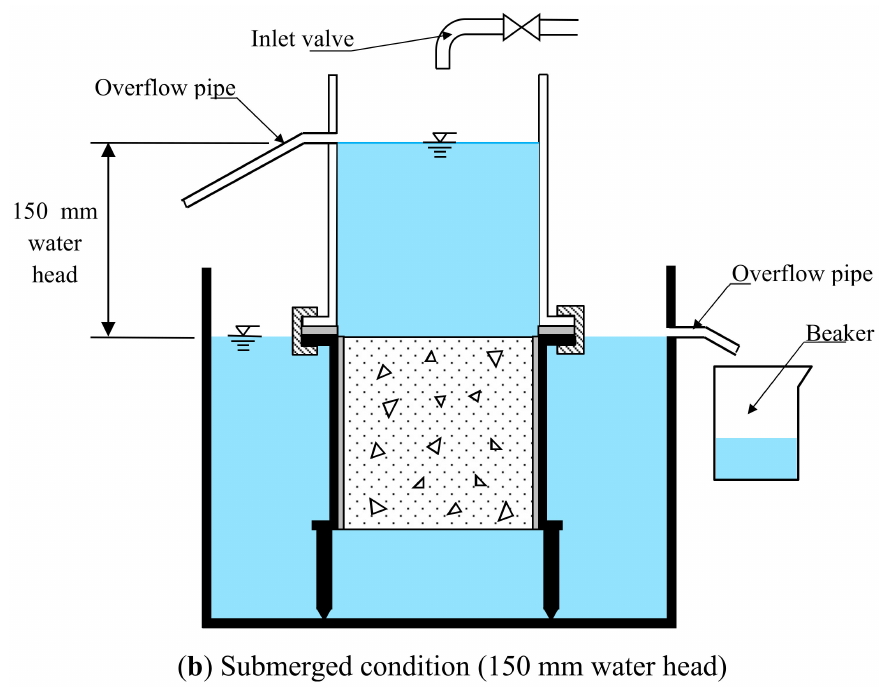
Figure 6. Schematic diagram of permeability test.